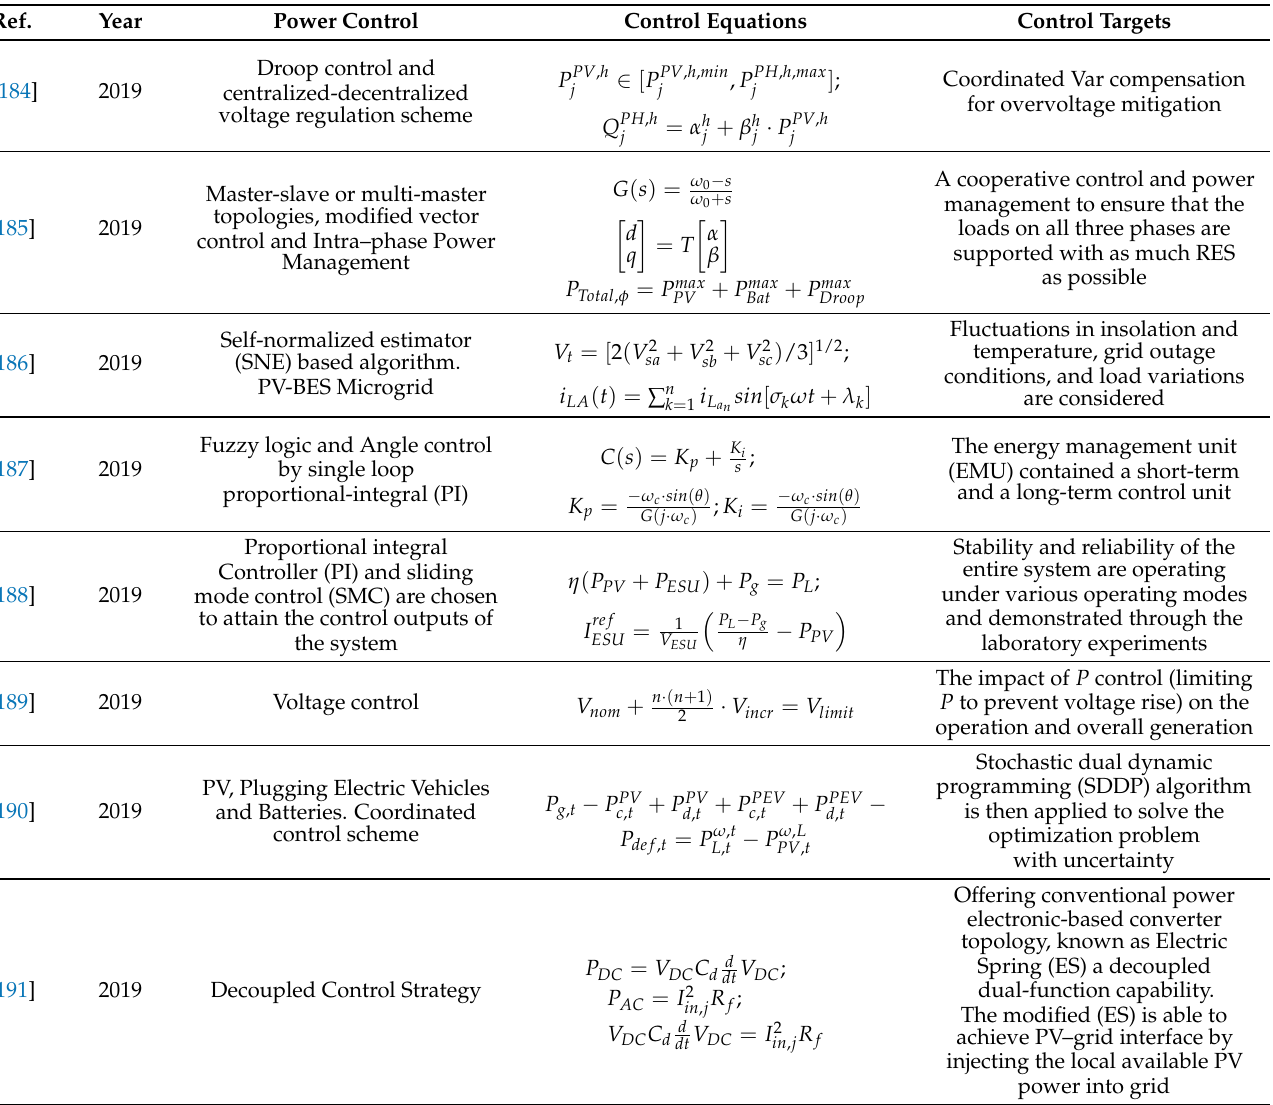
Table 8. Inverter control approaches